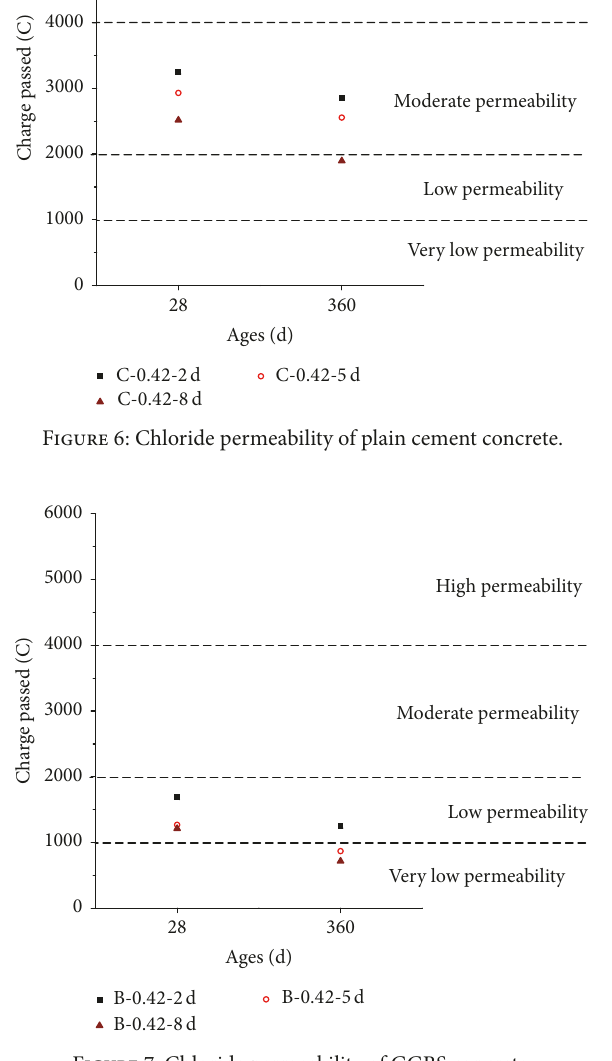
Figure 7: Chloride permeability of GGBS concrete.